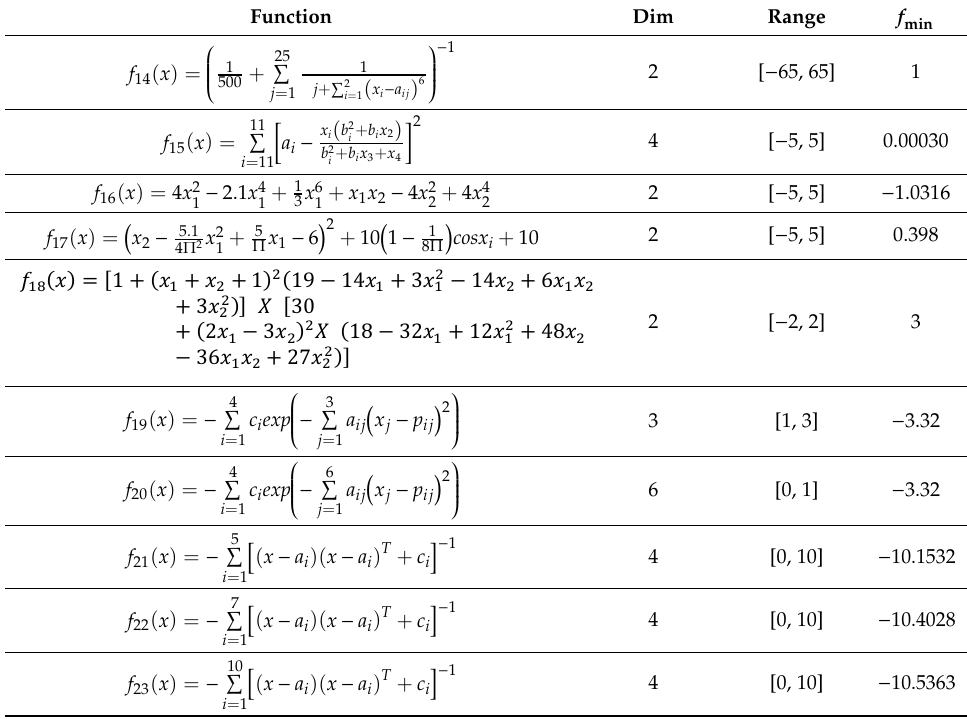
Table 3. Fixed dimension benchmark.